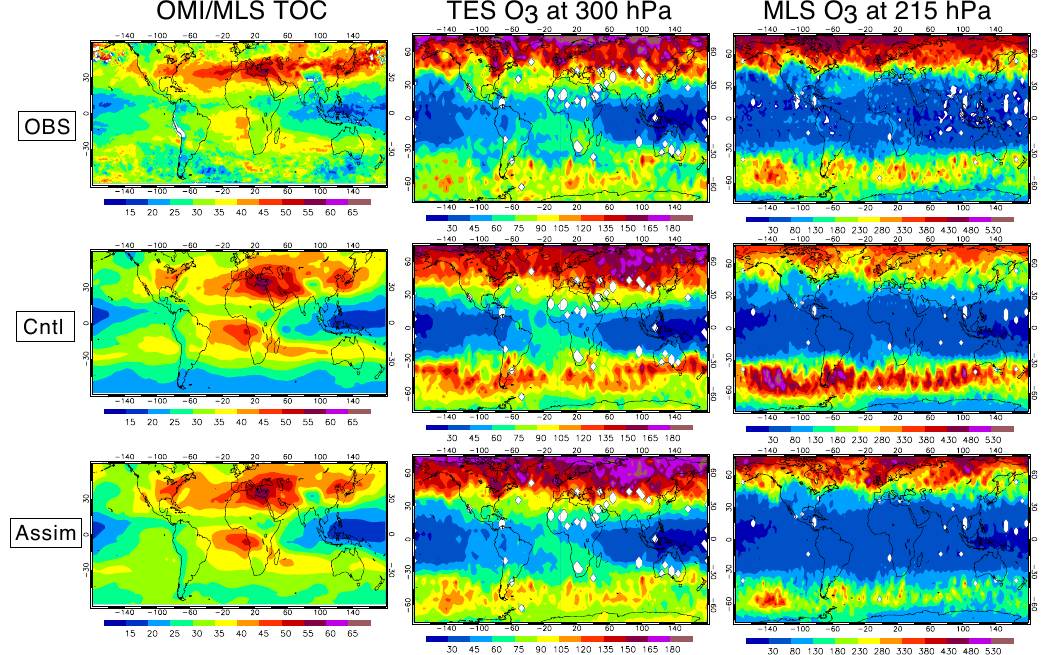
Fig. 9. Global distributions of the tropospheric O 3 columns (in DU) and O 3 mixing ratio (in ppb), averaged over 16–30 July 2007. The results are shown for OML/MLS O 3 columns (left columns), TES O 3 mixing ratio at 300hPa (middle columns), and MLS O 3 mixing ratio at 215hPa (right columns). Upper rows show the satellite retrievals (OBS); centre rows from the control run (Cntl); and lower rows from the data assimilation run (Assim). The red (blue) colour indicates relatively high (low)